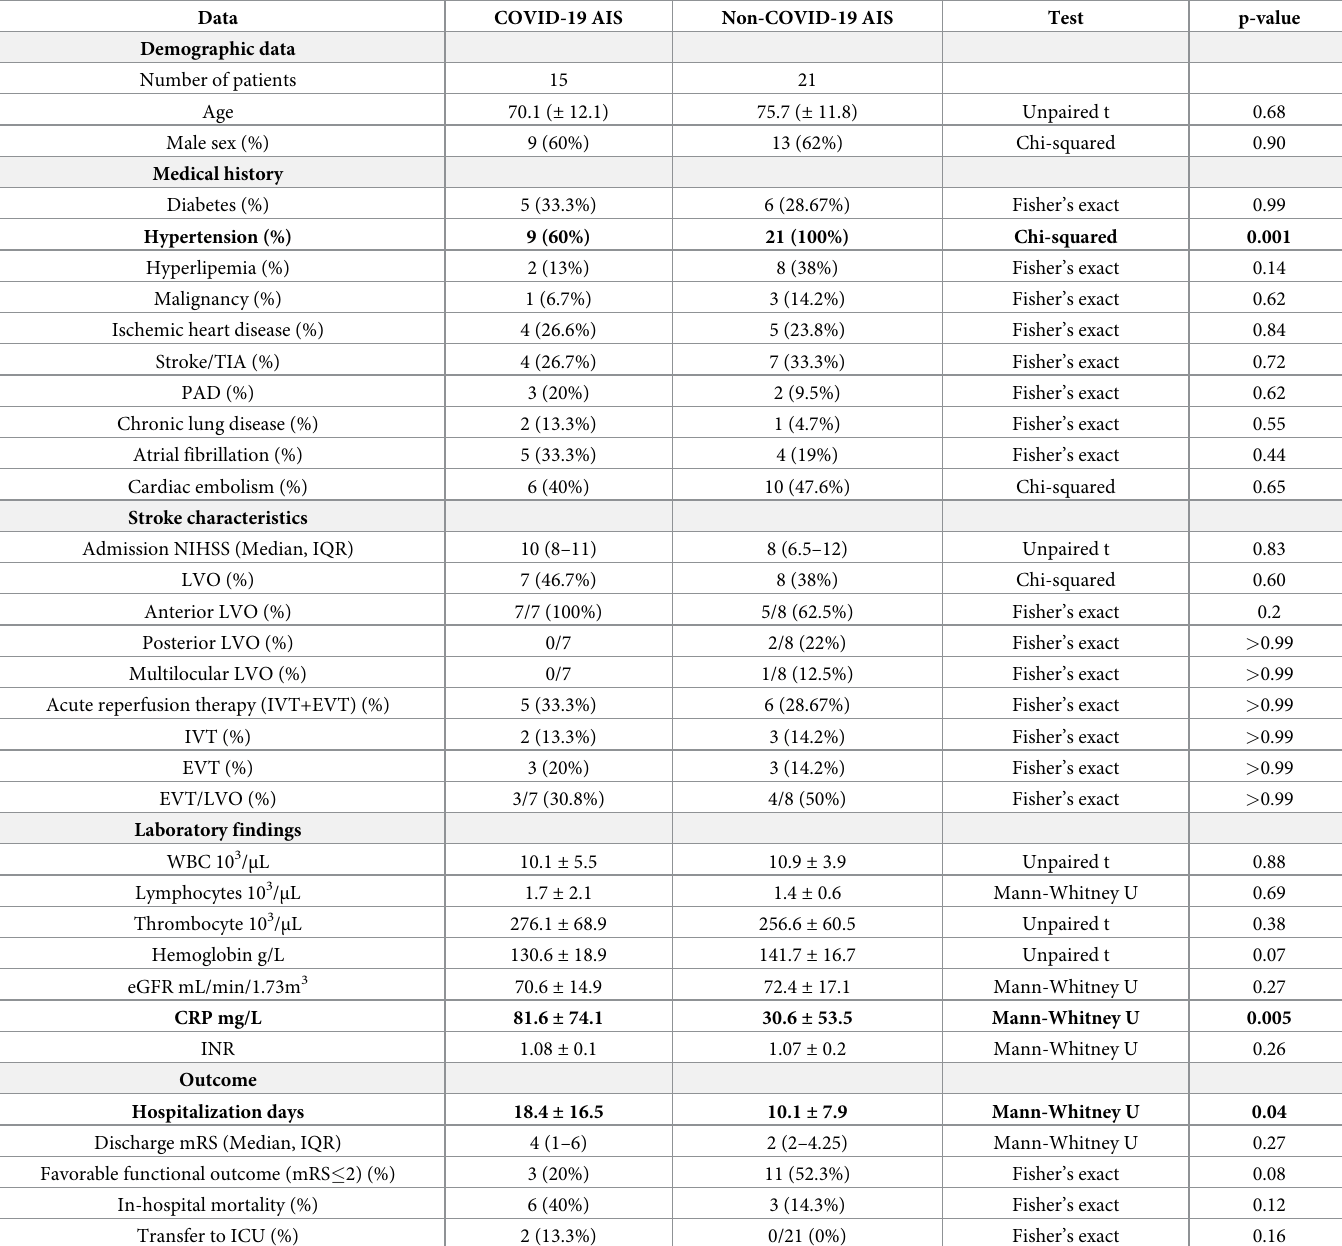
Table 3. Comparing characteristics of COVID-19 AIS with non-COVID-19 AIS patients in NIHSS range